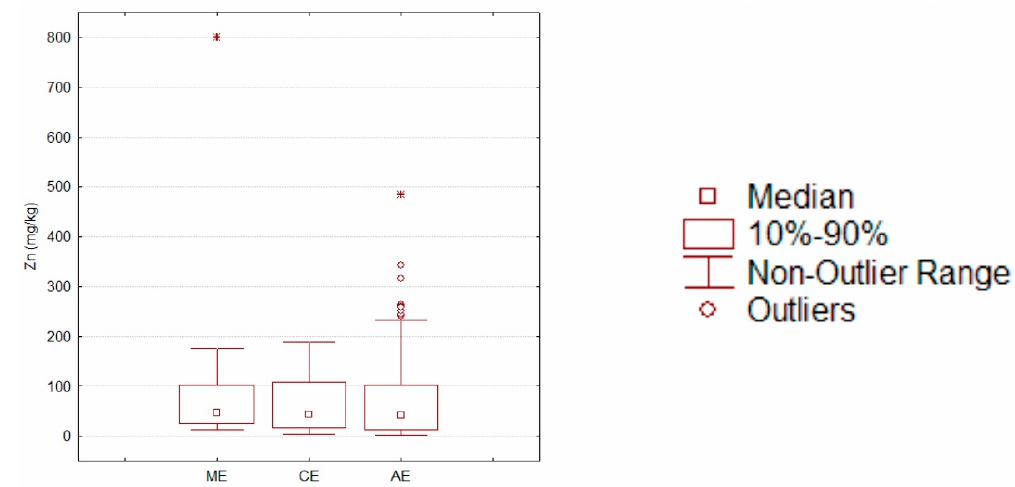
Figure 2. Box-and whisker plots of As, Cd, Cu, Cr, Hg, Pb, Ni, Se, and Zn in soils under different patterns of ecosystem. ME = mining ecosystem; CE = city ecosystem; AE = agricultural ecosystem.